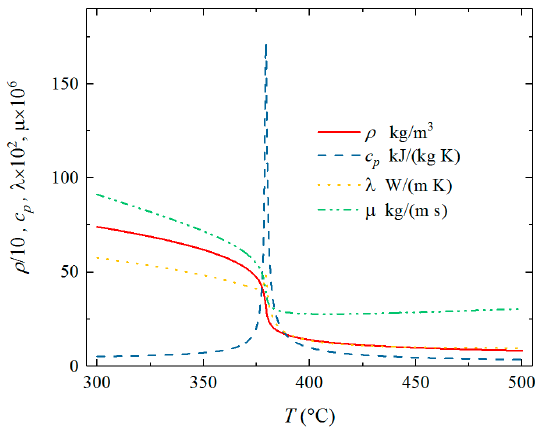
Figure 1. Thermophysical properties for water at 23.0 Mpa.